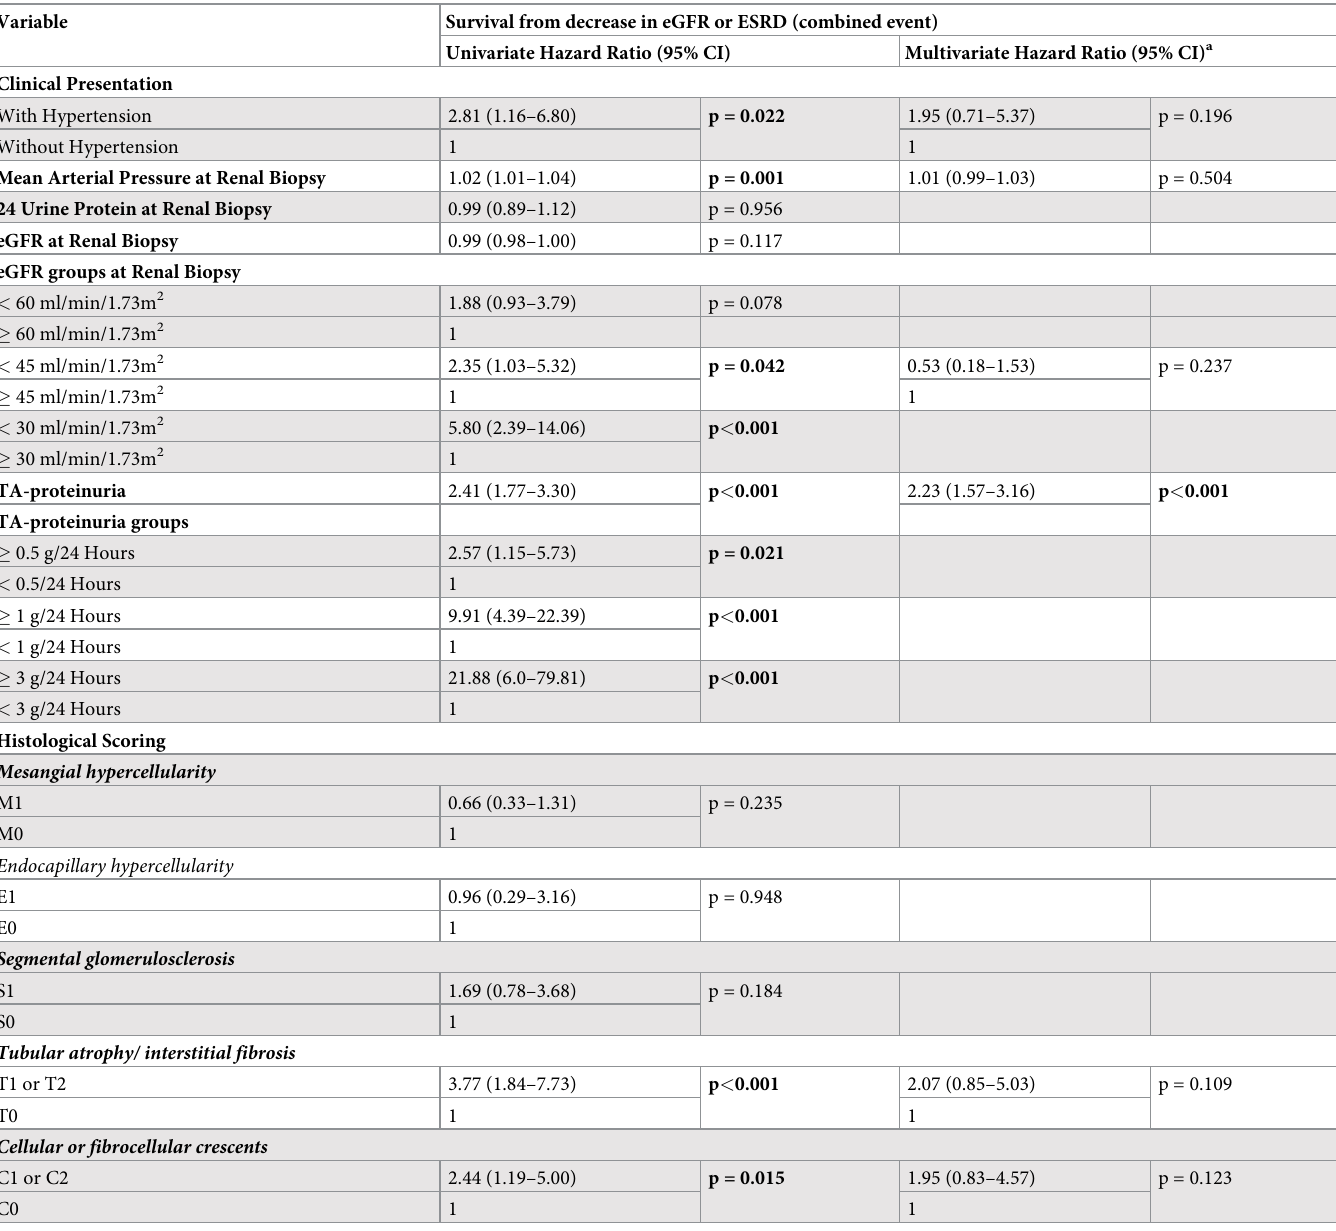
Table 4. Correlations between clinical, laboratory and pathology with renal